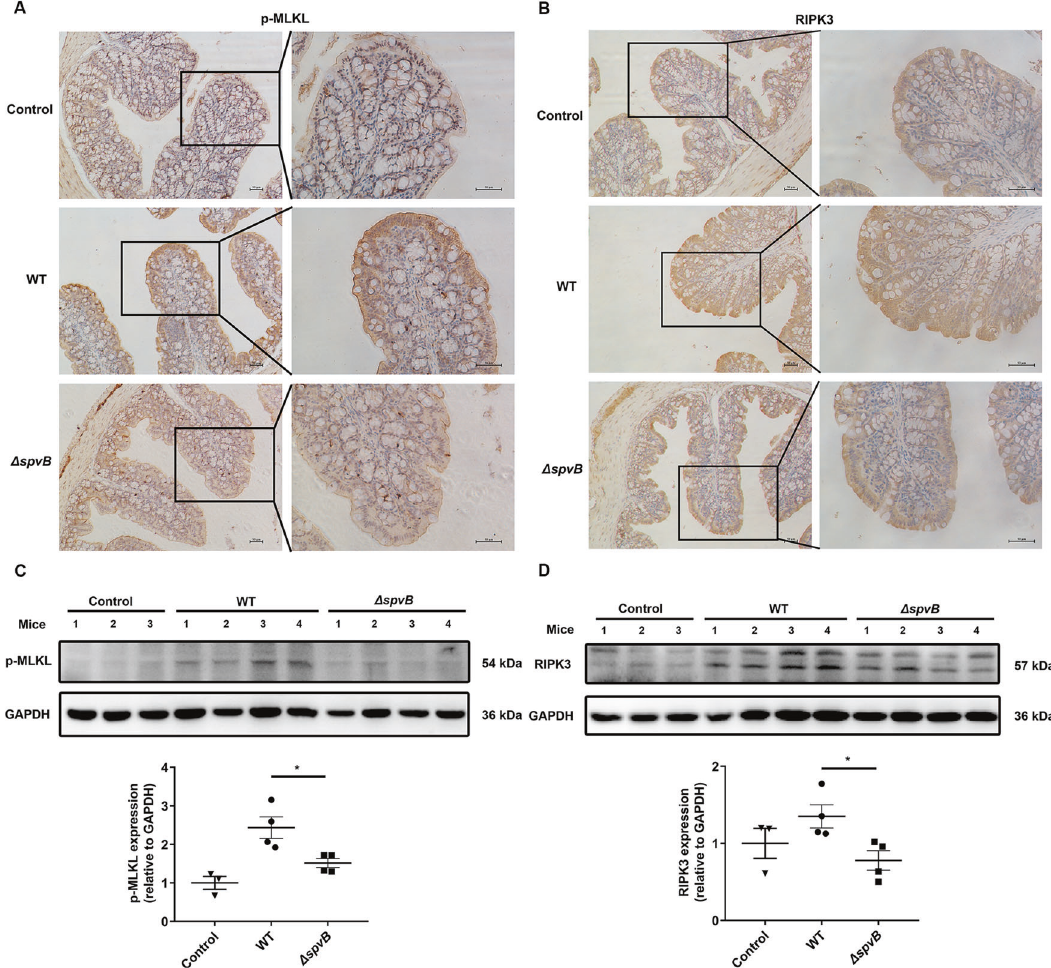
Fig. 6 SpvB promotes necroptosis of IECs in vivo. A , B C57BL/6 mice were treated with streptomycin 24 h prior to oral infection with the WT or Δ spvB S . Typhimurium strain (1 × 10 8 CFUs) and analyzed at 48 h. IHC staining evaluated the level of A p-MLKL and B RIPK3 in colon sections. Scale bars: 50 μ m. C , D Western blot analysis of puri fi ed colonic epithelial lysates with speci fi c antibodies to C p-MLKL and D RIPK3, n = 3 mice for control group, n = 4 mice for WT- and Δ spvB- infected group respectively. Data were analyzed with IBM SPSS Statistics 19 and presented as the mean ± SEM using Student ’ s t -test. * P <